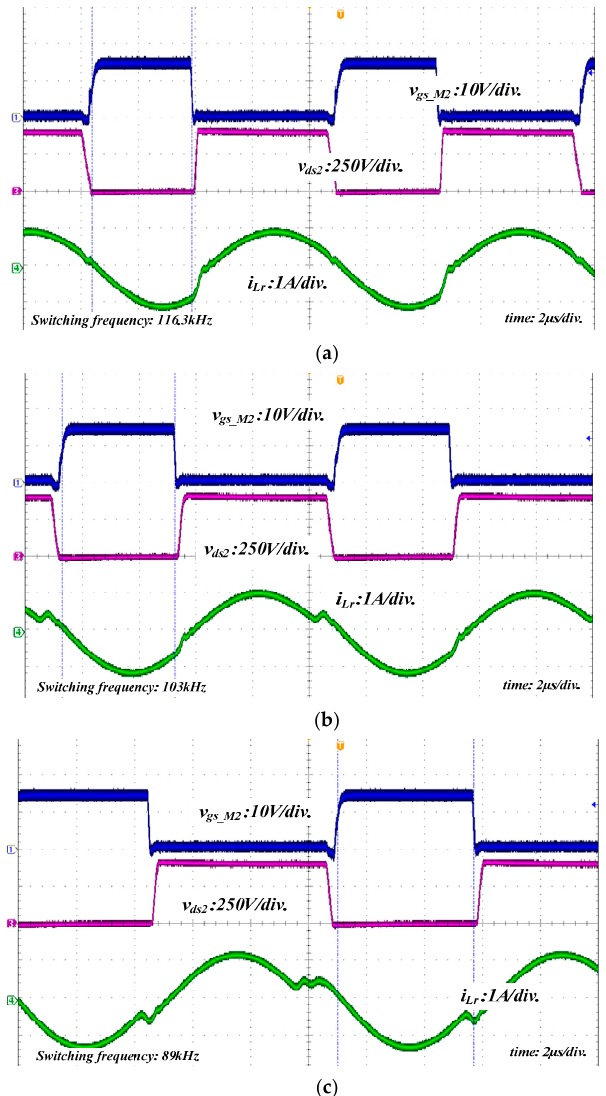
Figure 6. Experimental waveforms. ( a ) − 10% difference ( b ) 0% difference ( c ) +10% difference.